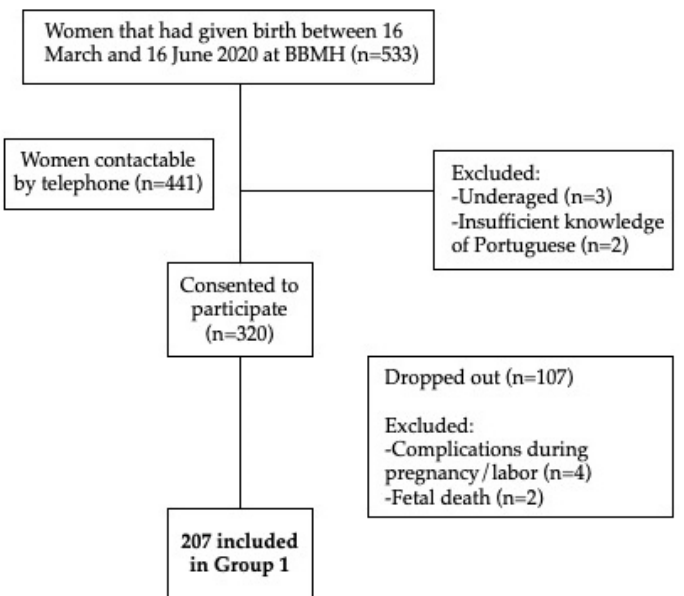
Figure 1. Flow chart of recruitment and screening.